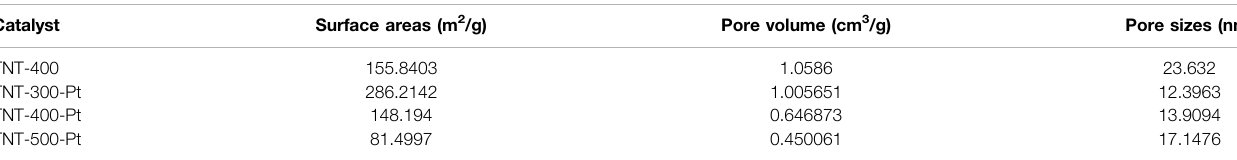
TABLE 1 | Surface areas and particle sizes of TNT-400 and TNT-Pt photocatalysts.